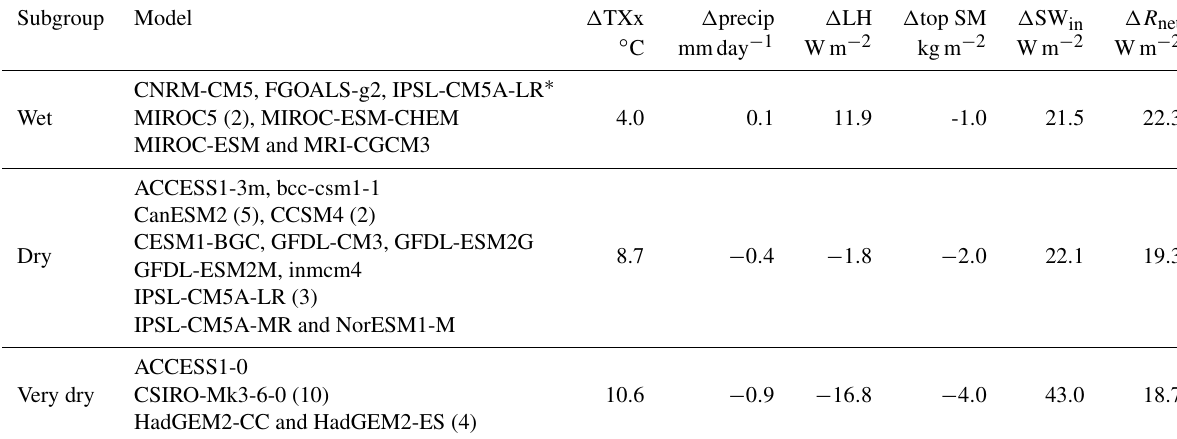
Table 1. Classification of CMIP5 models into three subgroups. Changes of the multi-model median of TXx, precipitation (precip), latent heat flux (LH), top soil moisture (top SM), incoming shortwave radiation (SW in ) and net radiation ( R net ) are shown between the periods from 2081 to 2100 and from 1950 to 1969. The number in brackets corresponds to the number of ensemble members. If not indicated then only one ensemble member is used.